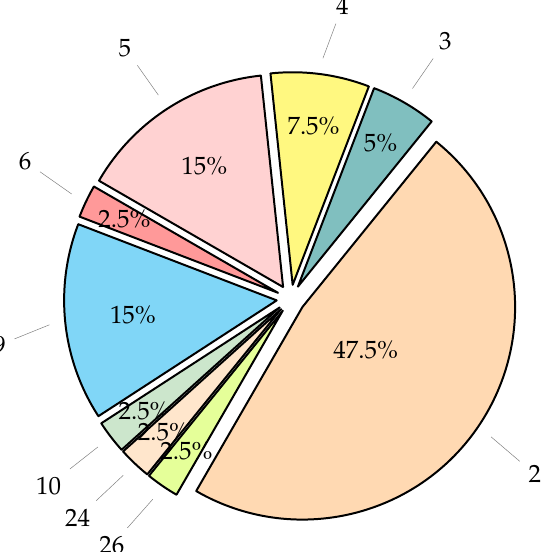
Figure 9. Distribution of reviewed IML methods with respect to the number of disease